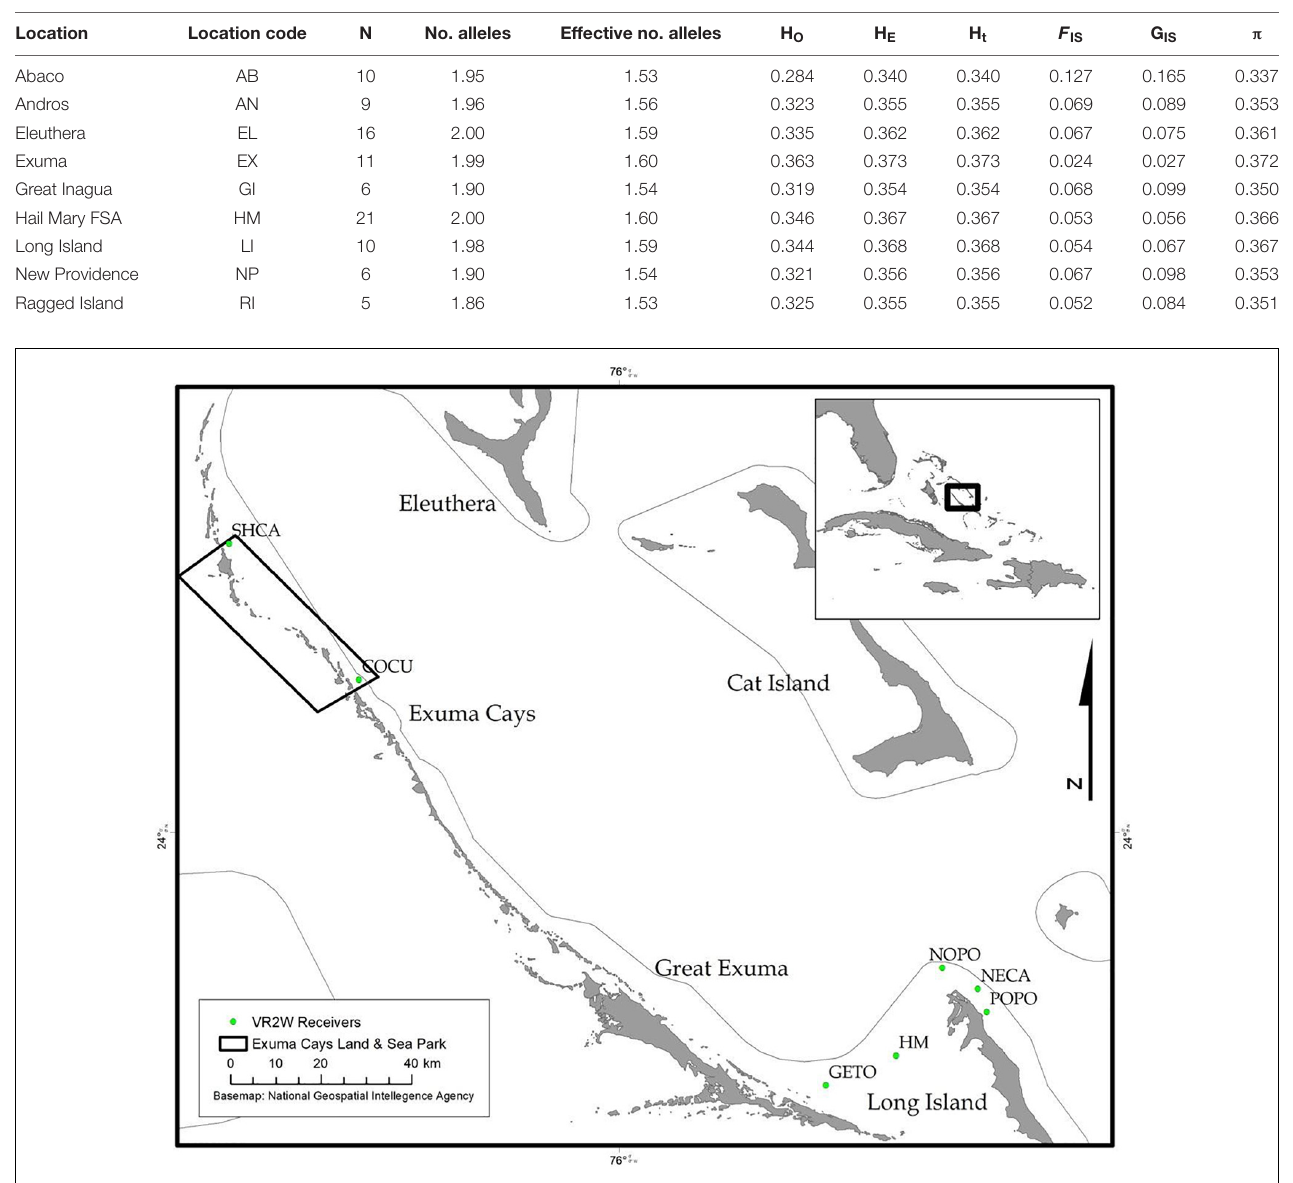
TABLE 1 | Summary indices of genetic diversity per location based on 10,031 loci. Location